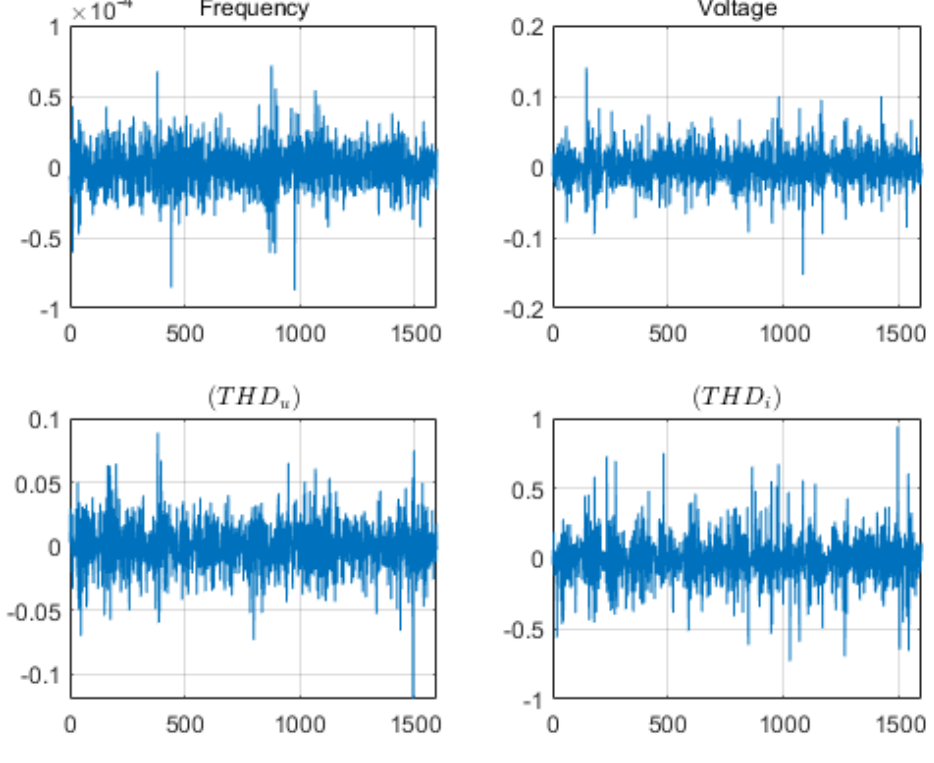
Figure 7. Residual results of the frequency, voltage, THD u , and THD i of the training phase of boosting